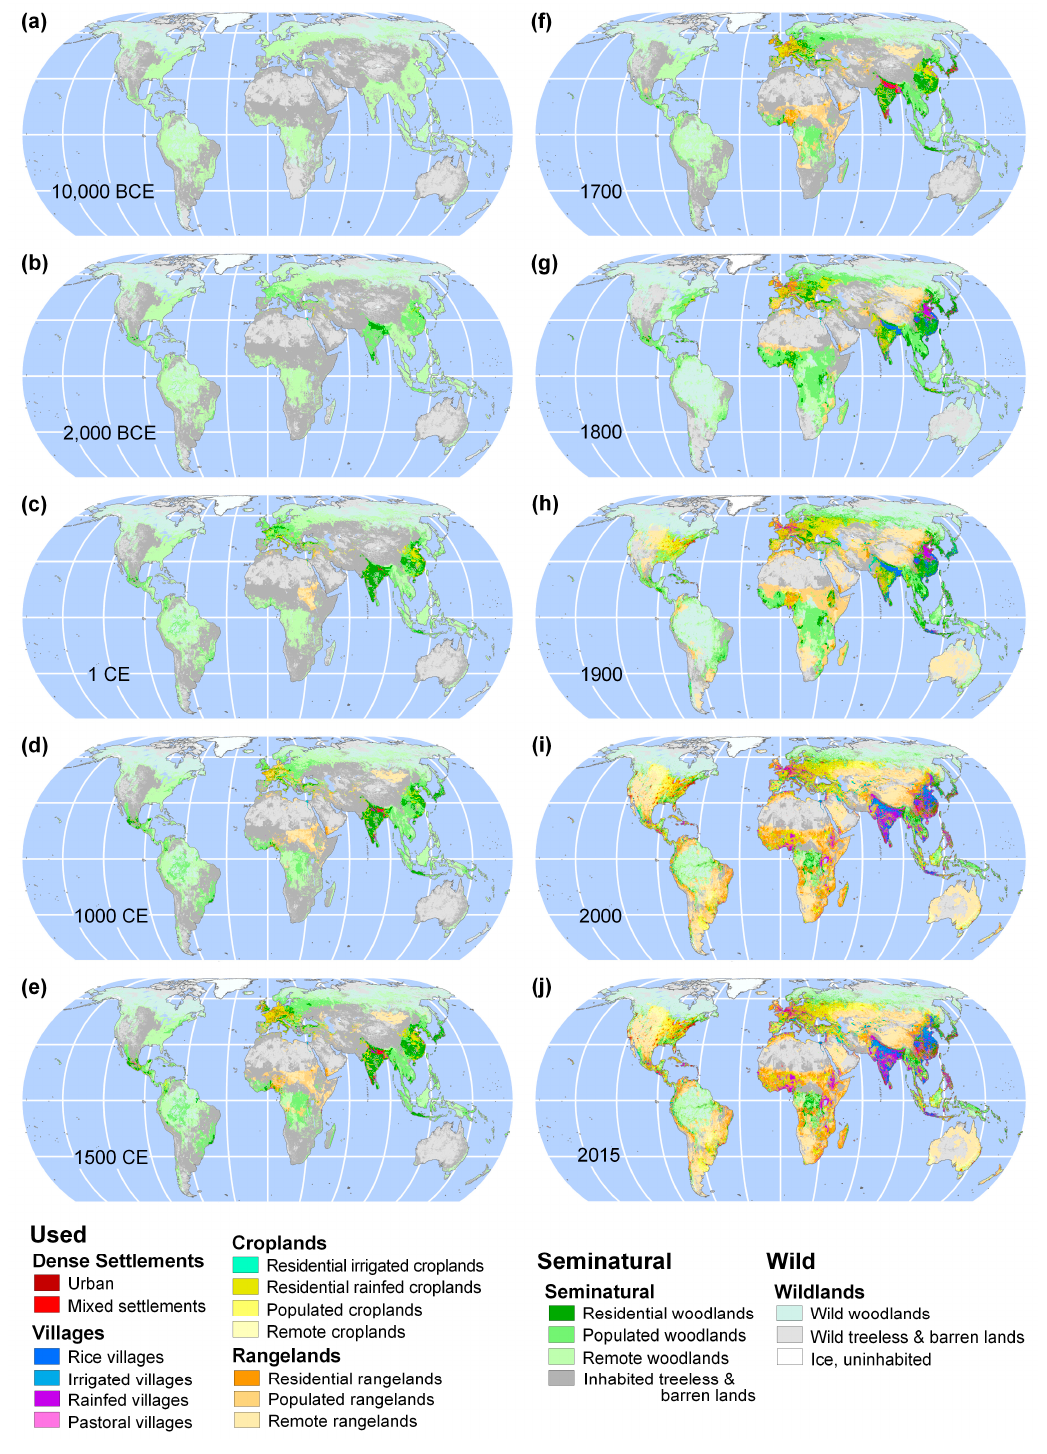
Figure 4. Anthromes 12K maps for selected times; ( a ) 10,000 BCE, ( b ) 2,000 BCE, ( c ) 1 CE, ( d ) 1000 CE, ( e ) 1500 CE, ( f ) 1700 CE, ( g ) 1800 CE, ( h ) 1900 CE, ( i ) 2000 CE, ( j ) 2015 CE. Eckert IV projection.